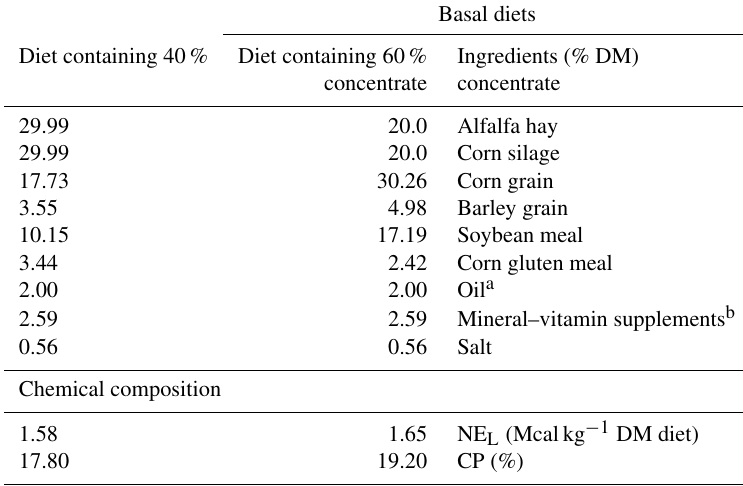
Table 1. Ingredients and chemical composition of the experimental diets.